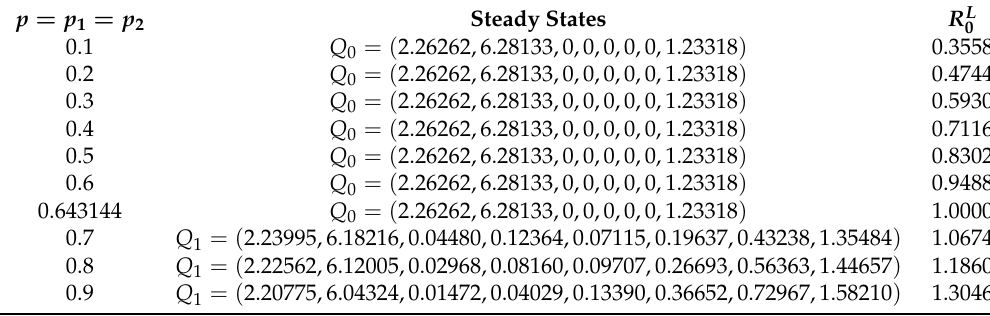
Table 3. The values of steady states, R L